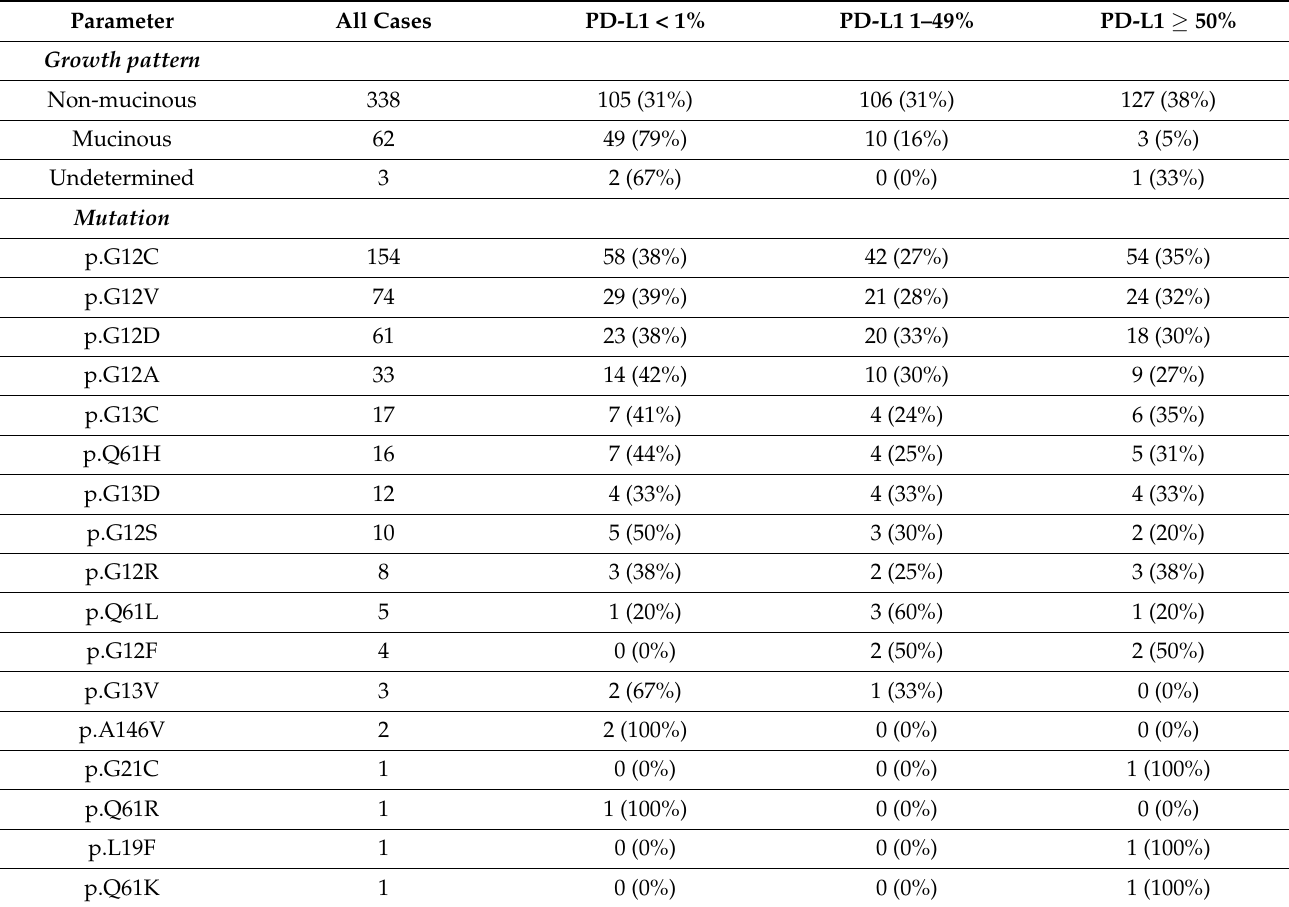
Table 3. PD-L1 expression in KRAS -mutated lung adenocarcinomas from the two cohorts